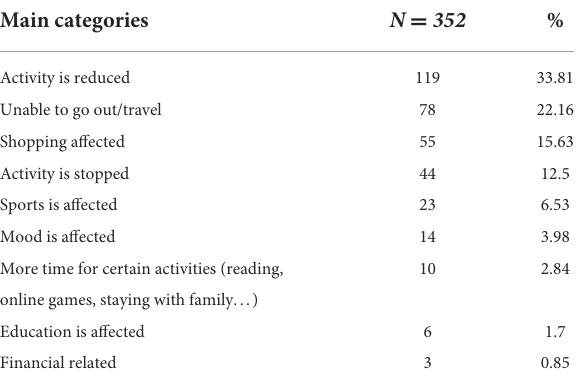
TABLE 6 Examples of how participants’ activities are